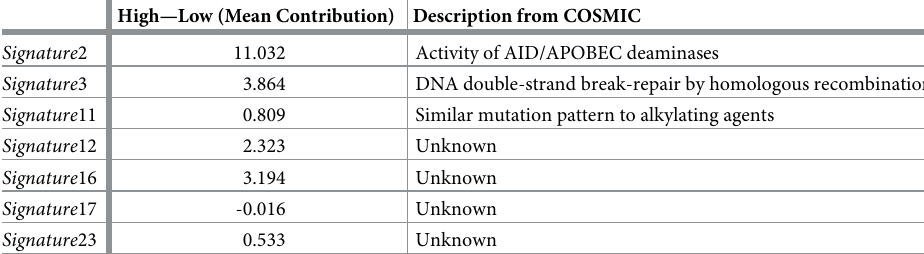
Table 1. COSMIC mutation signatures associated with RAD51C-202